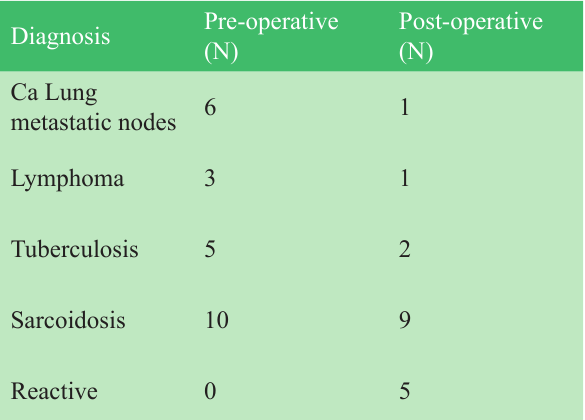
Table. Pre-operative and post-operative diagnosis of patients who underwent